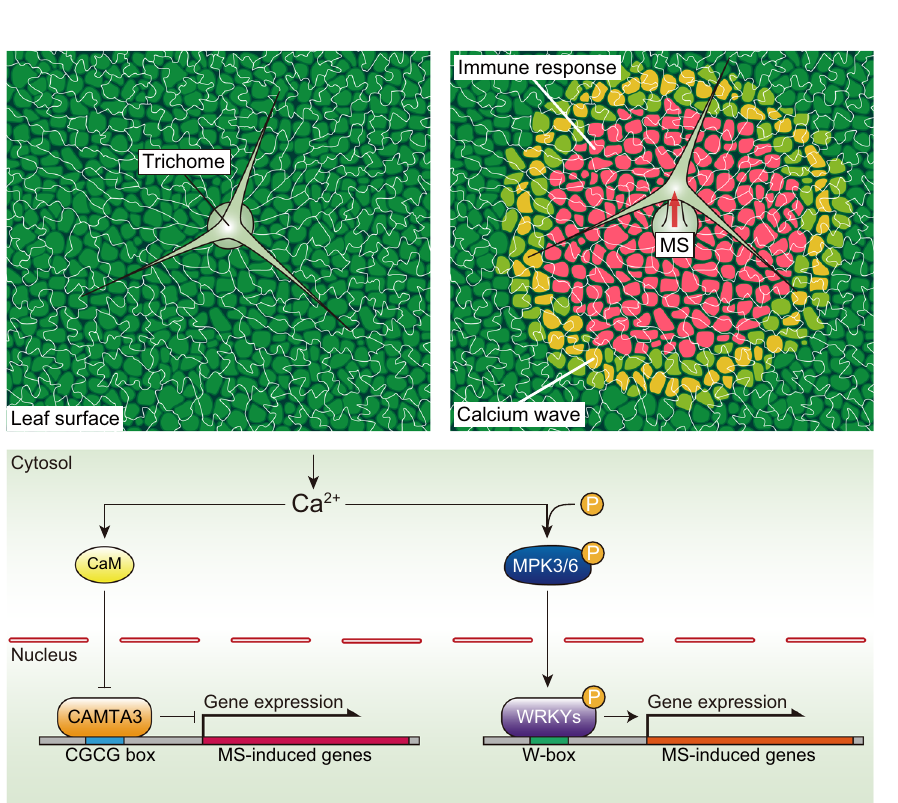
Fig. 6 Mechanosensory trichomes evoke an immune response. Model showing how trichomes directly sense the mechanical impact of raindrops as an emergency signal in anticipation of possible infections. Mechanosensory trichome cells initiate intercellular calcium waves in response to MS. [Ca 2 + ] cyt initiates the de-repression of Ca 2 + /CaM-dependent CAMTA3 and activates the phosphorylation of MPK3 and MPK6, thereby inducing WRKY-dependent